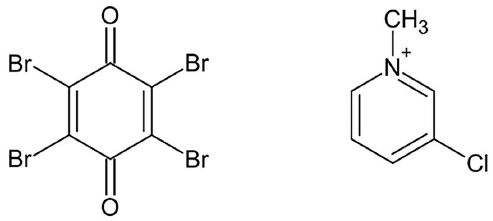
Figure 2 Tetrabromoquinone and 3-Cl- N -MePy